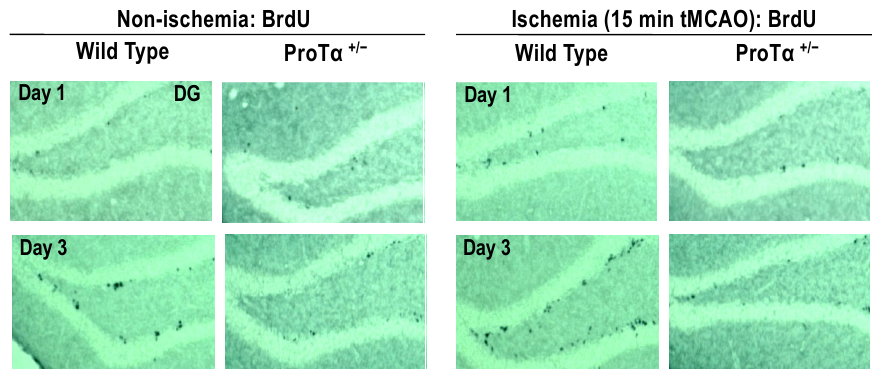
Figure 5. Involvement of ProT α in adult neurogenesis. The results show the representative images showing 5 ‐ bromo ‐ 2 ′‐ deoxyuridine (BrdU) ‐ labeled cells in the sub ‐ granular zone of the hippocampal dentate gyrus (DG) in wild-type and ProT α +/ − mice, as reported elsewhere [49]. Mice received intraperitoneal (i.p.) injections of 50 mg/kg BrdU once a day for three consecutive days. All mice were killed 24 h after last BrdU injection. BrdU labeling in the brain was analyzed by immunohistochemistry. Some BrdU signals in the DG of wild-type mice were observed at day 3, but not day 1, showing that it is a de novo signal. In the DG of ProT α +/ − mouse, on the other hand, BrdU signals were lost. When transit MCAO (15 min) was given to wild-type mouse, more BrdU signals were observed in the wider region of sub-granular zone of DG, while no BrdU signals were observed in the DG of ProT α +/ − mouse. These results suggest that ProT α is involved not only in naturally occurring adult neurogenesis, but also in the stroke-induced increase in